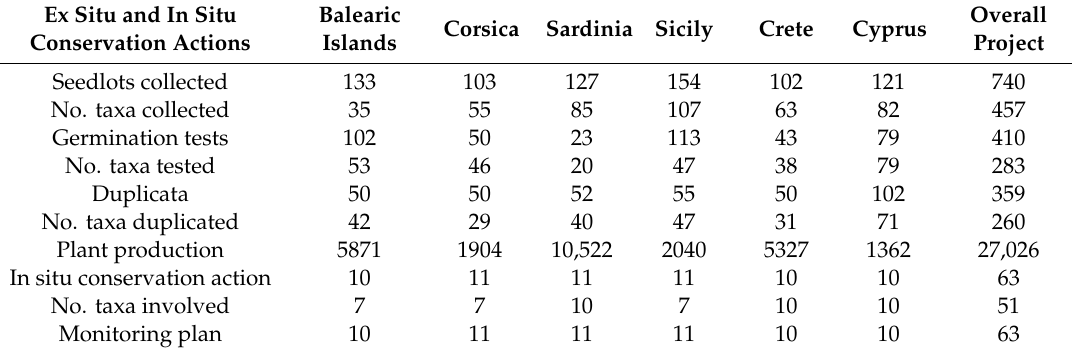
Table 2. Overall number of the conservation actions, both ex and in situ, at the island level. Ex Situ and In